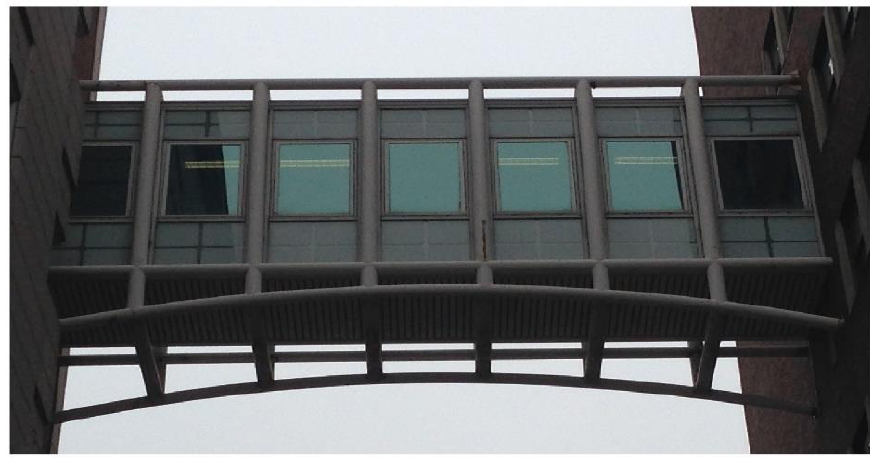
Figure 2. Mudd Schapiro Link Bridge.